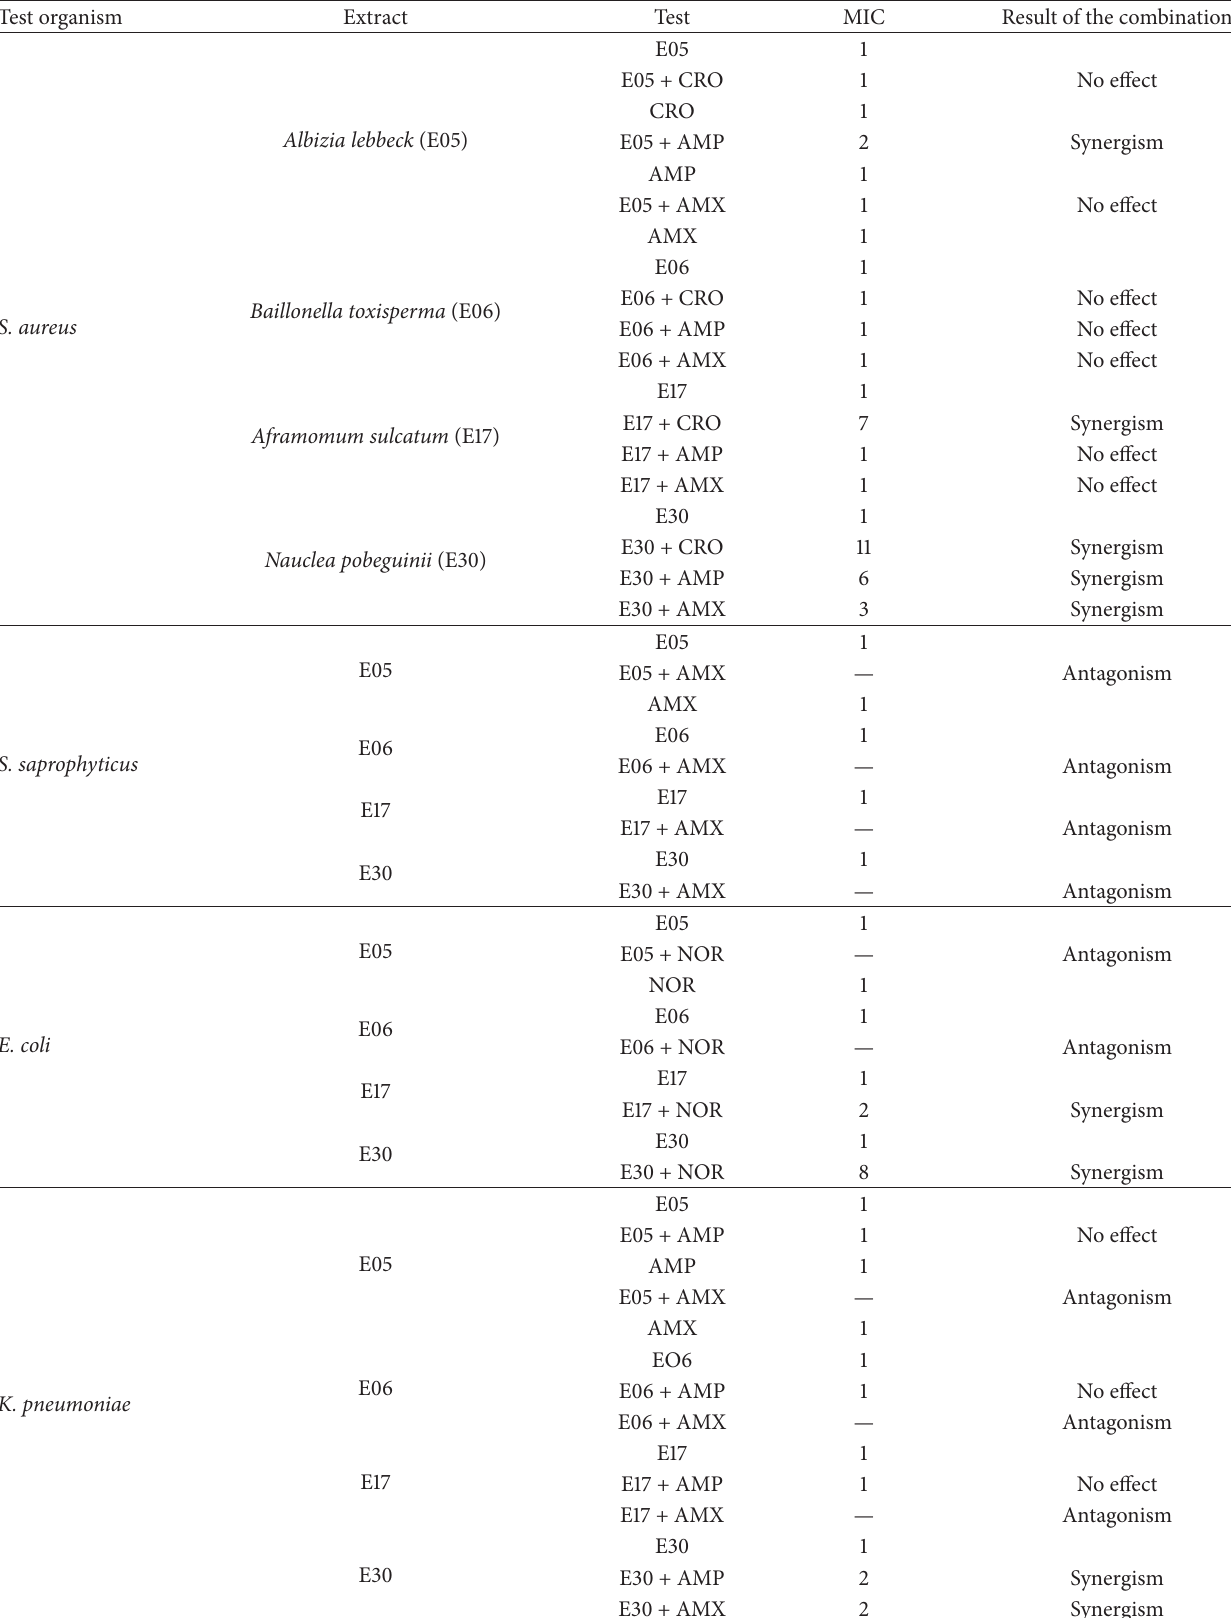
Table 8: Synergism of extracts (E05, E06, E17, and E30) with antibiotics (CRO, AMP, AMX, and NOR) to which bacteria is resistant. Test